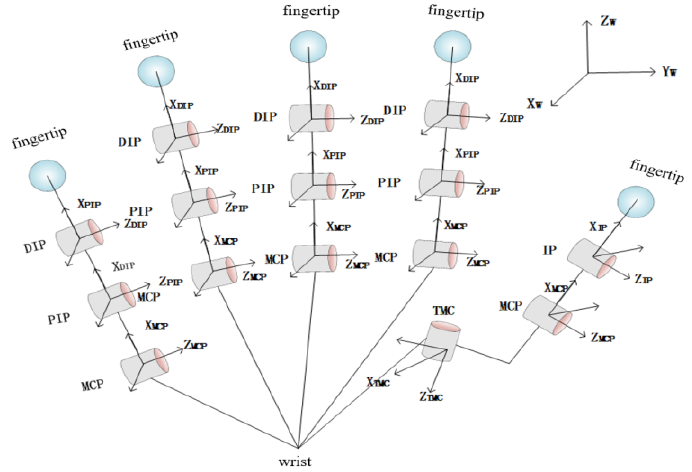
Figure 8. Complete manipulator joint link model.